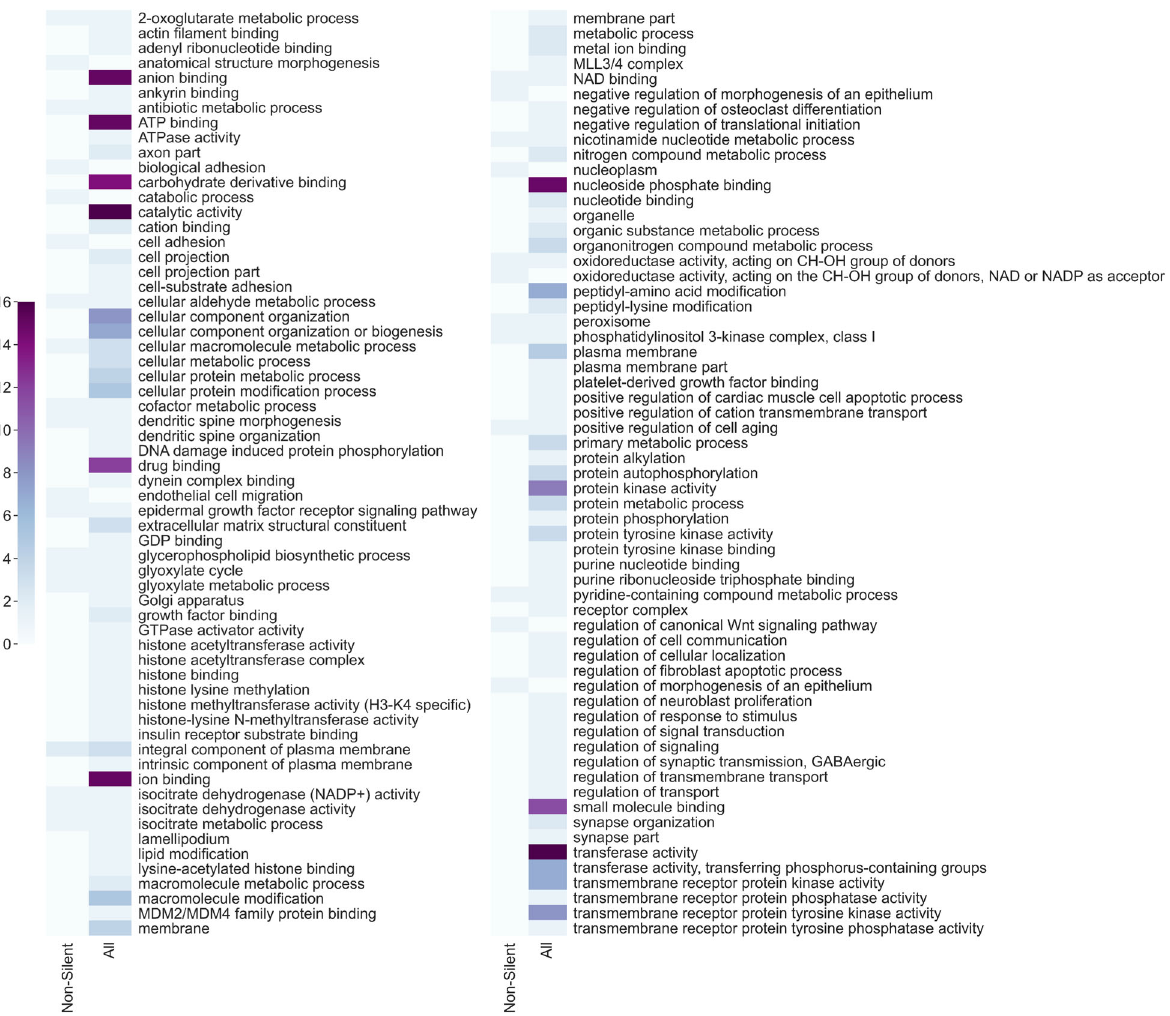
Fig. 8 The number of cancer types for which a GO term was enriched using gene rankings from the non-silent models and all features models. The fi gure is constructed of two panels for readability purposes and is equivalent to a single long panel with 123 GO terms. Each row in a panel refers to a GO term and every column in a panel refers to a model from which the gene ranking list was used as input for the GOrilla